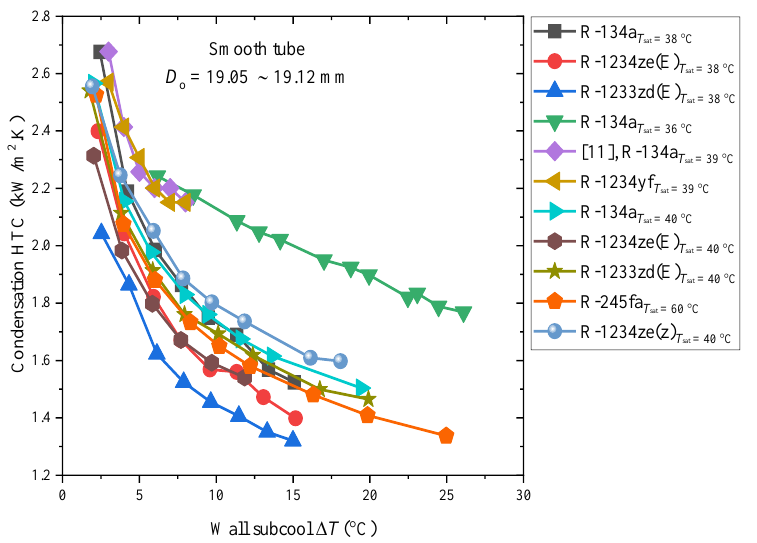
Figure 3. Condensation HTC of various low-GWP refrigerants alternative to R-134a on smooth tube. Rectangular, circular, and triangular upward solid connected line presents the Ko and Jeon [9] study, triangular downward solid connected lines present Ji et al. [10] study, star and triangular backward solid connected lines presents the Park et al. [11] study, remaining symbols presents the Nagata et al. [12] study.